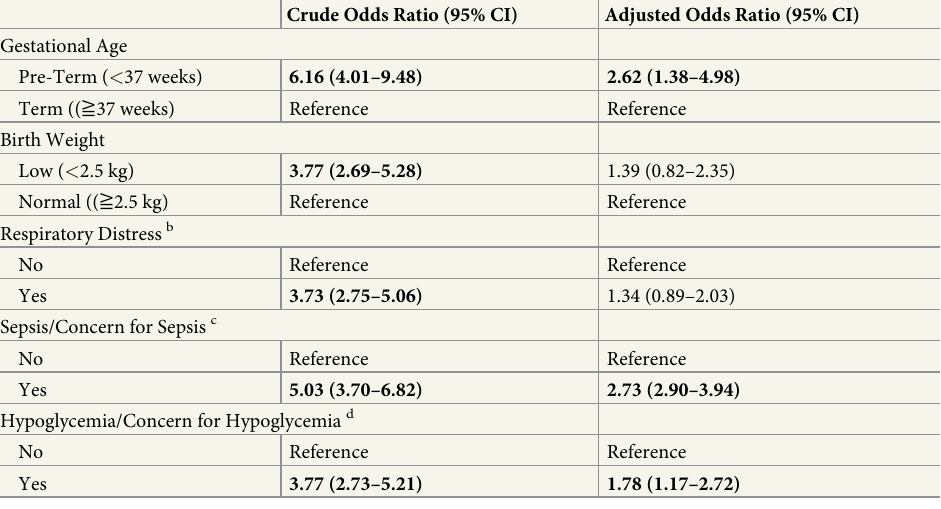
Table 2. Multivariable logistic regression of clinical characteristics associated with neonatal hypothermia a